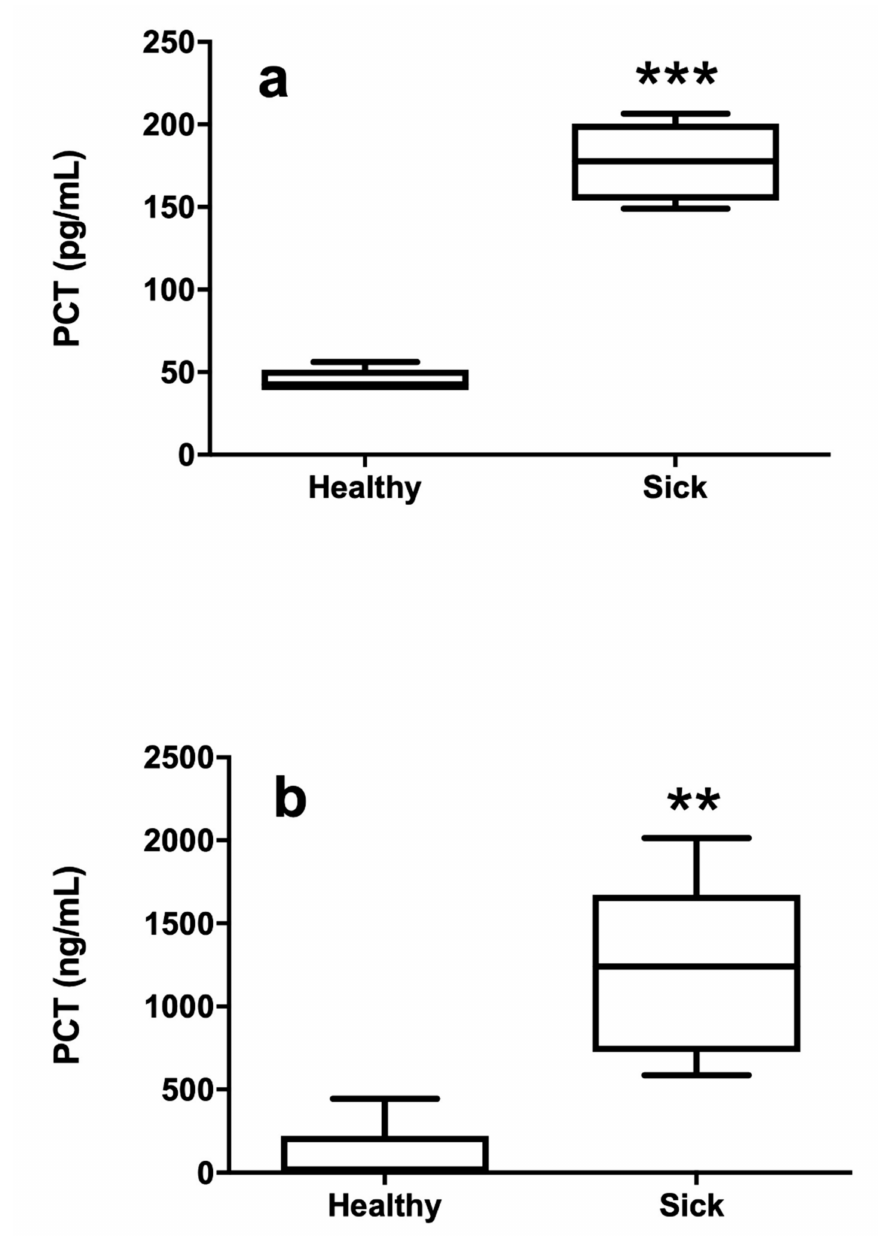
Figure 2. Concentrations of PCT measured by the ePCT ( a ) and hPCT ( b ) kits in healthy and sick equine plasma samples (** p < 0.01; *** p <